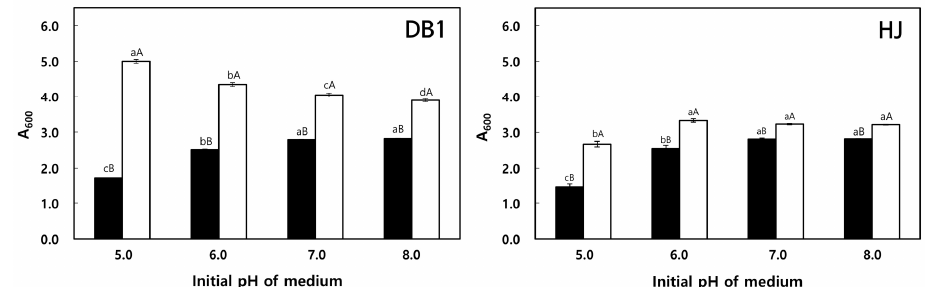
Figure 2. Effect of initial pH on LAB growth. Initial pH values of MRS ( ■ ) and MRS + 1.0% arginine ( □ ) were adjusted to 5.0–8.0, and then, W. koreensis DB1 or HJ were cultivated in these media for 24 h at 30 °C. Different lowercase letters indicate significant differences ( p < 0.05) between cultures with different initial pH values as determined by Duncan’s multiple range test. Different uppercase letters indicate significant differences ( p < 0.05) between cultures with or without arginine supplementation as determined by the independent-samples t test.